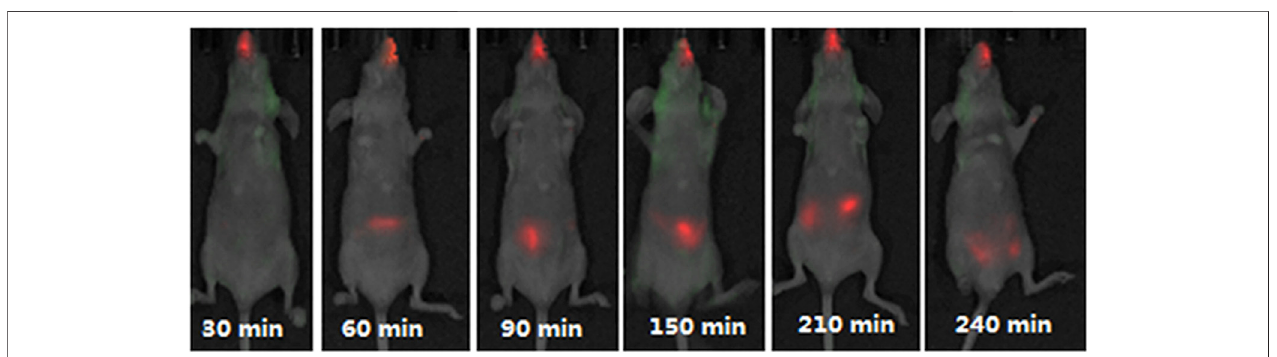
FIGURE3| FluorescencedetectedinmiceafterintranasaladministrationofCy5.5-markedanionicliposome/chitosan/DNAnanoparticlesatdifferenttimeintervals. Figure adopted from Chen et al. (2013) (https://creativecommons.org/licenses/by/4.0/).